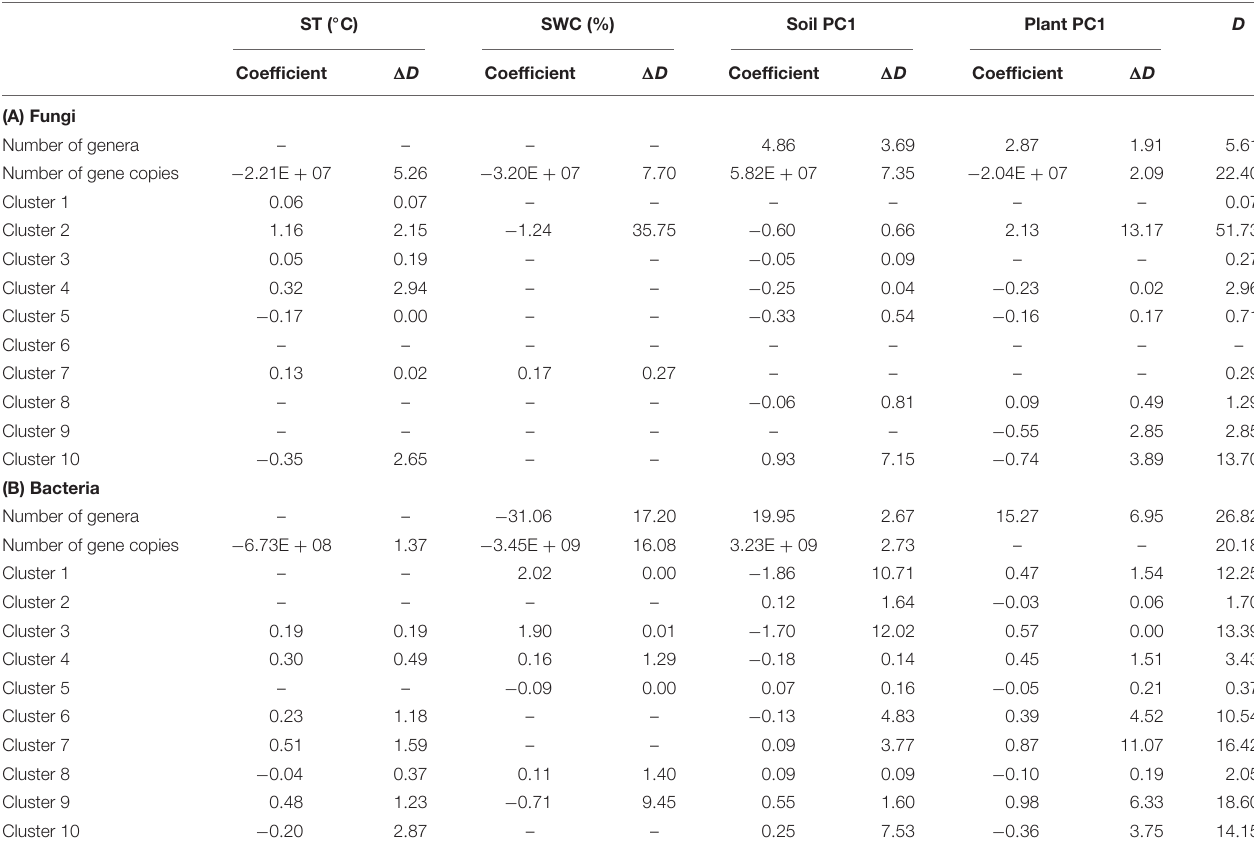
TABLE 4 | Results of backward selection of generalized linear models using environmental variables, soil temperature (ST), soil water content (SWC), and principal component (PC) axes of soil chemical properties and plant traits, to explain the number of genera and gene copies, and sequencing counts for each cluster as identified by finite mixture